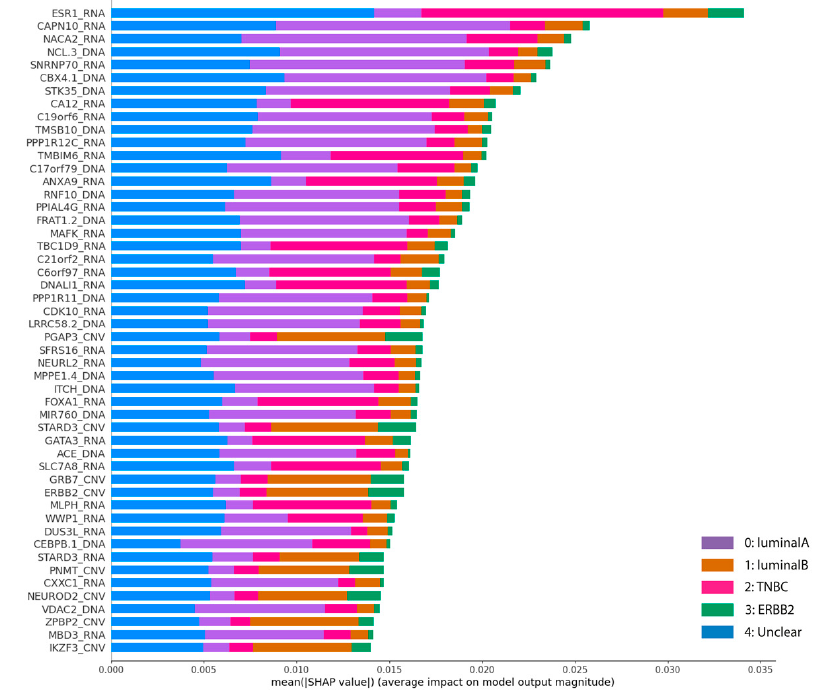
Figure 9. Contribution of the top 50 features into the classification process using extra trees on S2HT1 dataset.